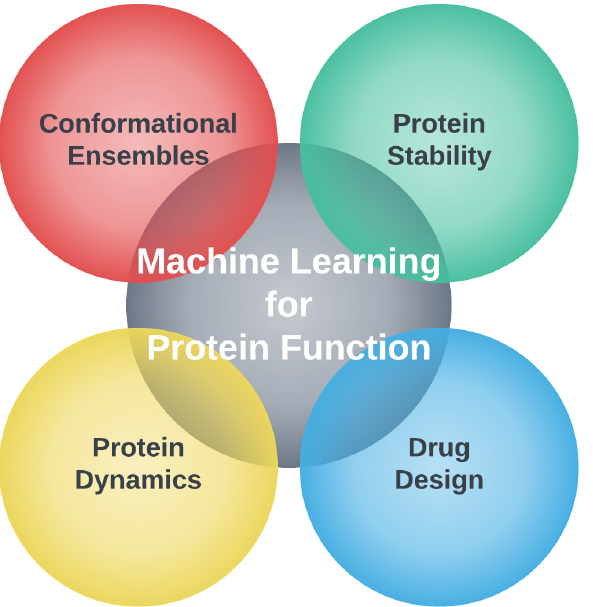
Figure 1. Machine learning meets computational biology. This review is about how machine learning (gray center circle) intersects with multiple aspects of computational biology (colored